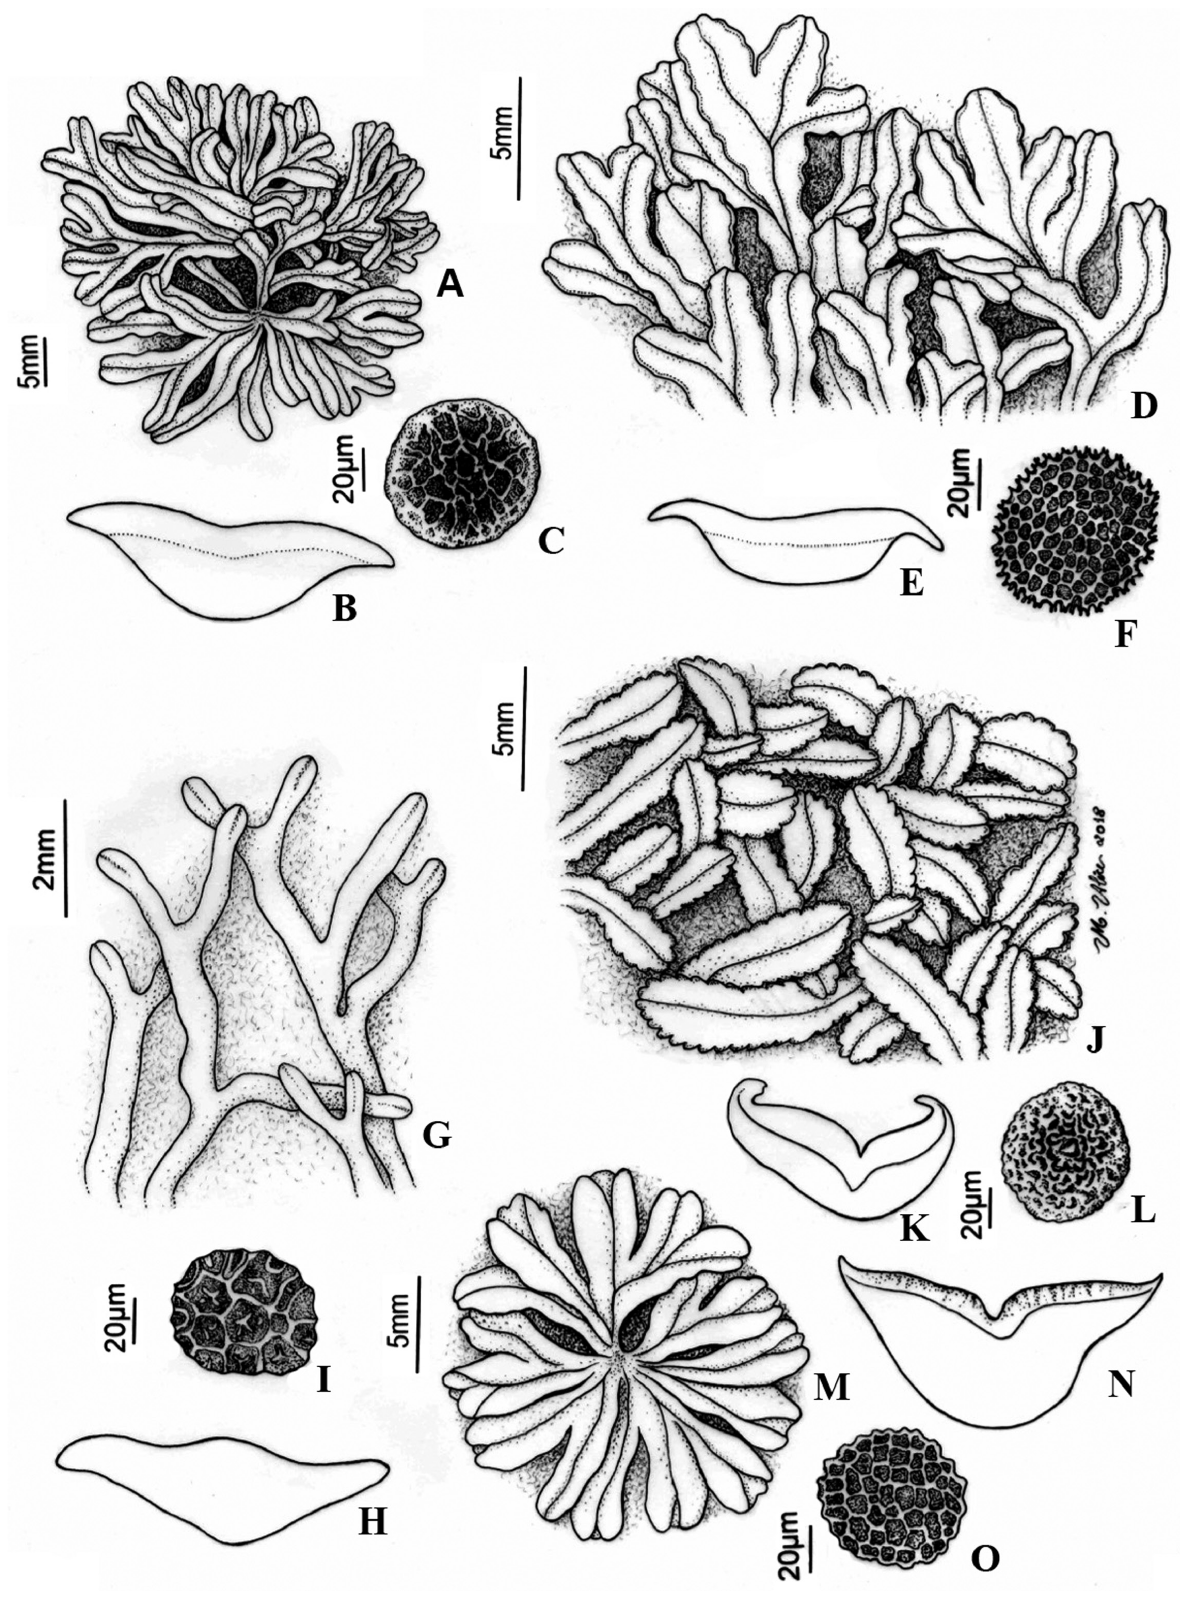
Figure 2. A – C. Riccia mauryana , A. thalli in gregarious patches, B. cross section of the thallus, C. spores D – F. Riccia planobiconvexa, D, thalli in gregarious patches, E. cross section of the thallus, F. spores G – I. Riccia stenophylla, G. thalli forming partial rosettes, H. cross section of the thallus, I. spores J – L. Riccia vitalii , J. thalli in gregarious patches, K. cross section of the thallus, L. spores M – O. Riccia weinionis, M. thalli forming rosettes, N. cross section of the thallus. O. spores. ( A – C. M. A. F Rodrigues and A.L.F. Rodrigues 52 (CCAA); D – F. E.S. Brito 23 (SP); G – I. M.A.F Rodrigues and A.L.F. Rodrigues 11 ; J – L J.A.S. Silva 85 (CCAA); M – O. J.A.S. Silva 135 (CCAA). Illustrations: Maria Alice de